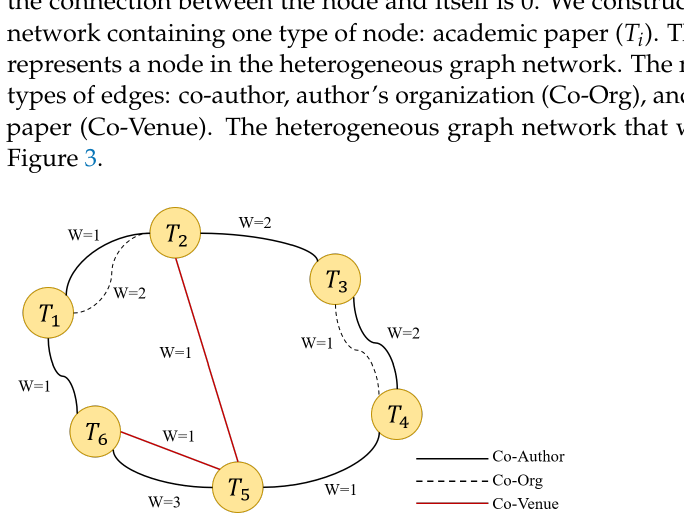
Figure 3. Local structure of heterogeneous graph network.